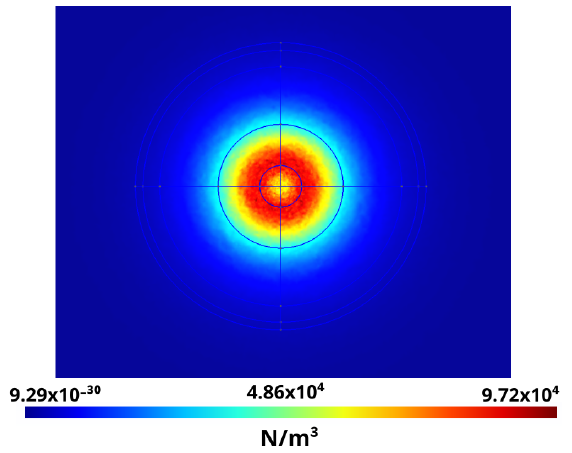
(cid:4666)𝜀 − 𝜀 (cid:4667) cut by the plane 1 X + 0 Y +0 Z − 0.0489 = 0. Figure 10. Kelvin force density divided by 1 2 ( ε − ε oil ) cut by the plane 1 X + 0 Y +0 Z − 0.0489 = 0.